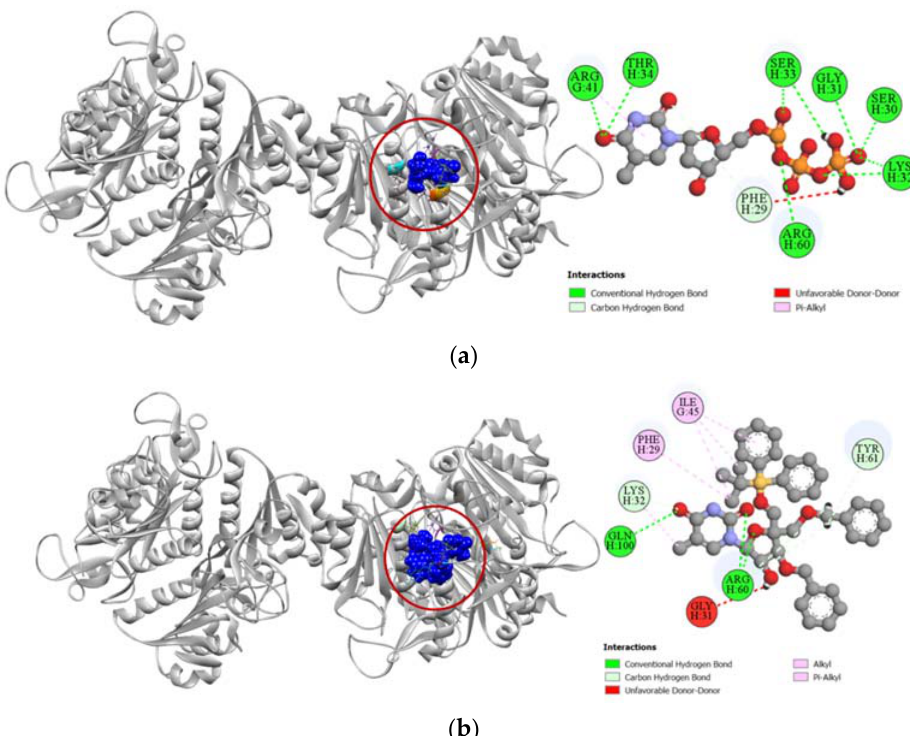
Figure 8. Pictorial representation (2D and 3D) of docking results for best-ranked pose of key inter- actions of ligands with the binding pocket of human thymidine kinase 1 (PDB: 1XBT). ( a ) Thymi- dine-5’-triphosphate with 1XBT; ( b ) compound 6 with 1XBT.